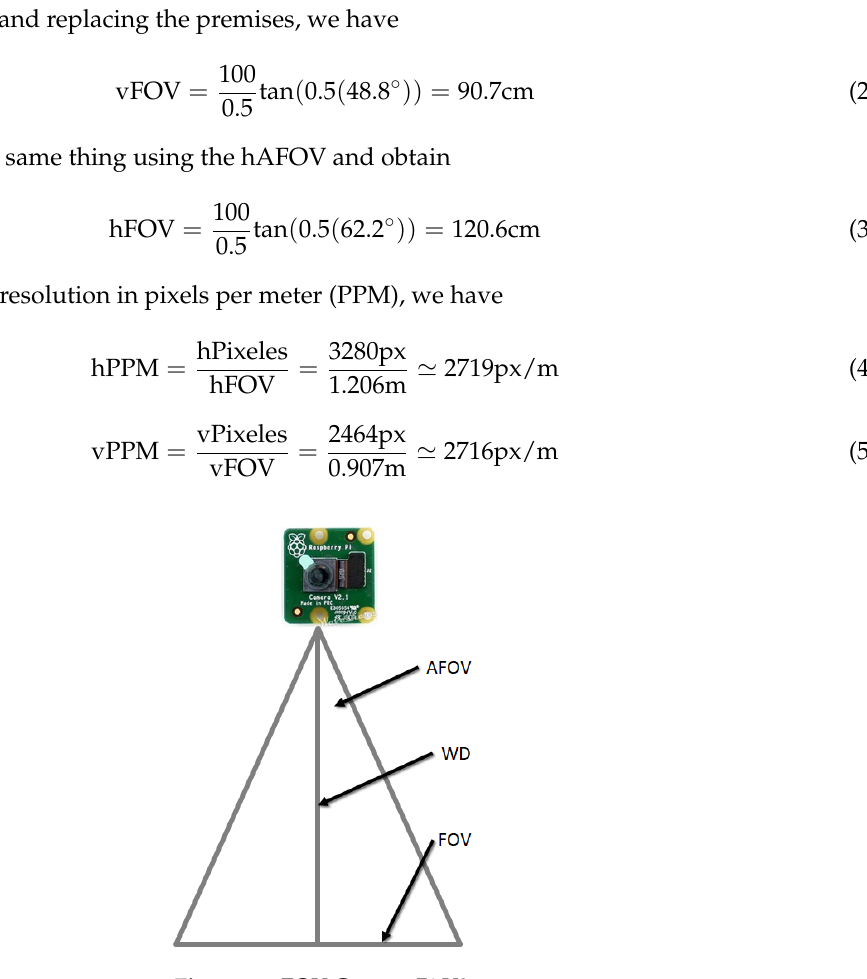
Figure 14. FOV Camera Pi